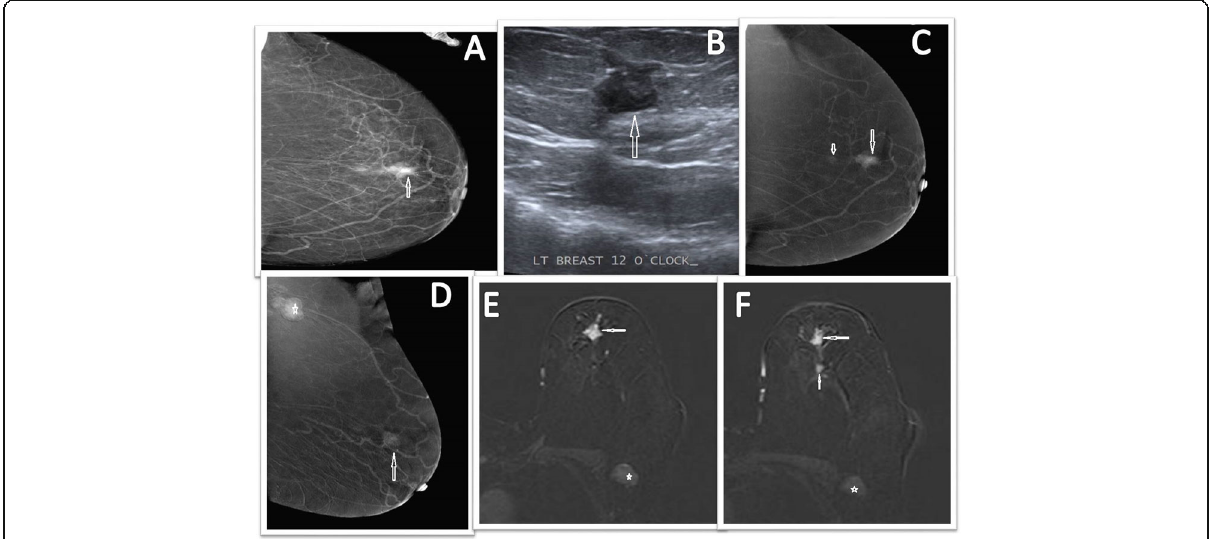
Fig. 3 Female patient 47 years old complaining of right breast mass. On conventional mammography ( a , b ), there was a segmental irregular lesion at the upper outer quadrant (arrows). On CESM ( c , d ), the lesion showed intense enhancement (arrows). It appeared as an irregular hypoechoic mass at the 10 o ’ clock with posterior acoustic enhancement on ultrasound ( e ) (arrows). No pathologically enlarged axially LNS. On CE-MRI ( f , g ), the lesion shows heterogenous segmental enhancement extending to the nipple with dynamic curve type III (arrows). An ultrasound guided core biopsy was done and histopathologically proven as granulomatous mastitis